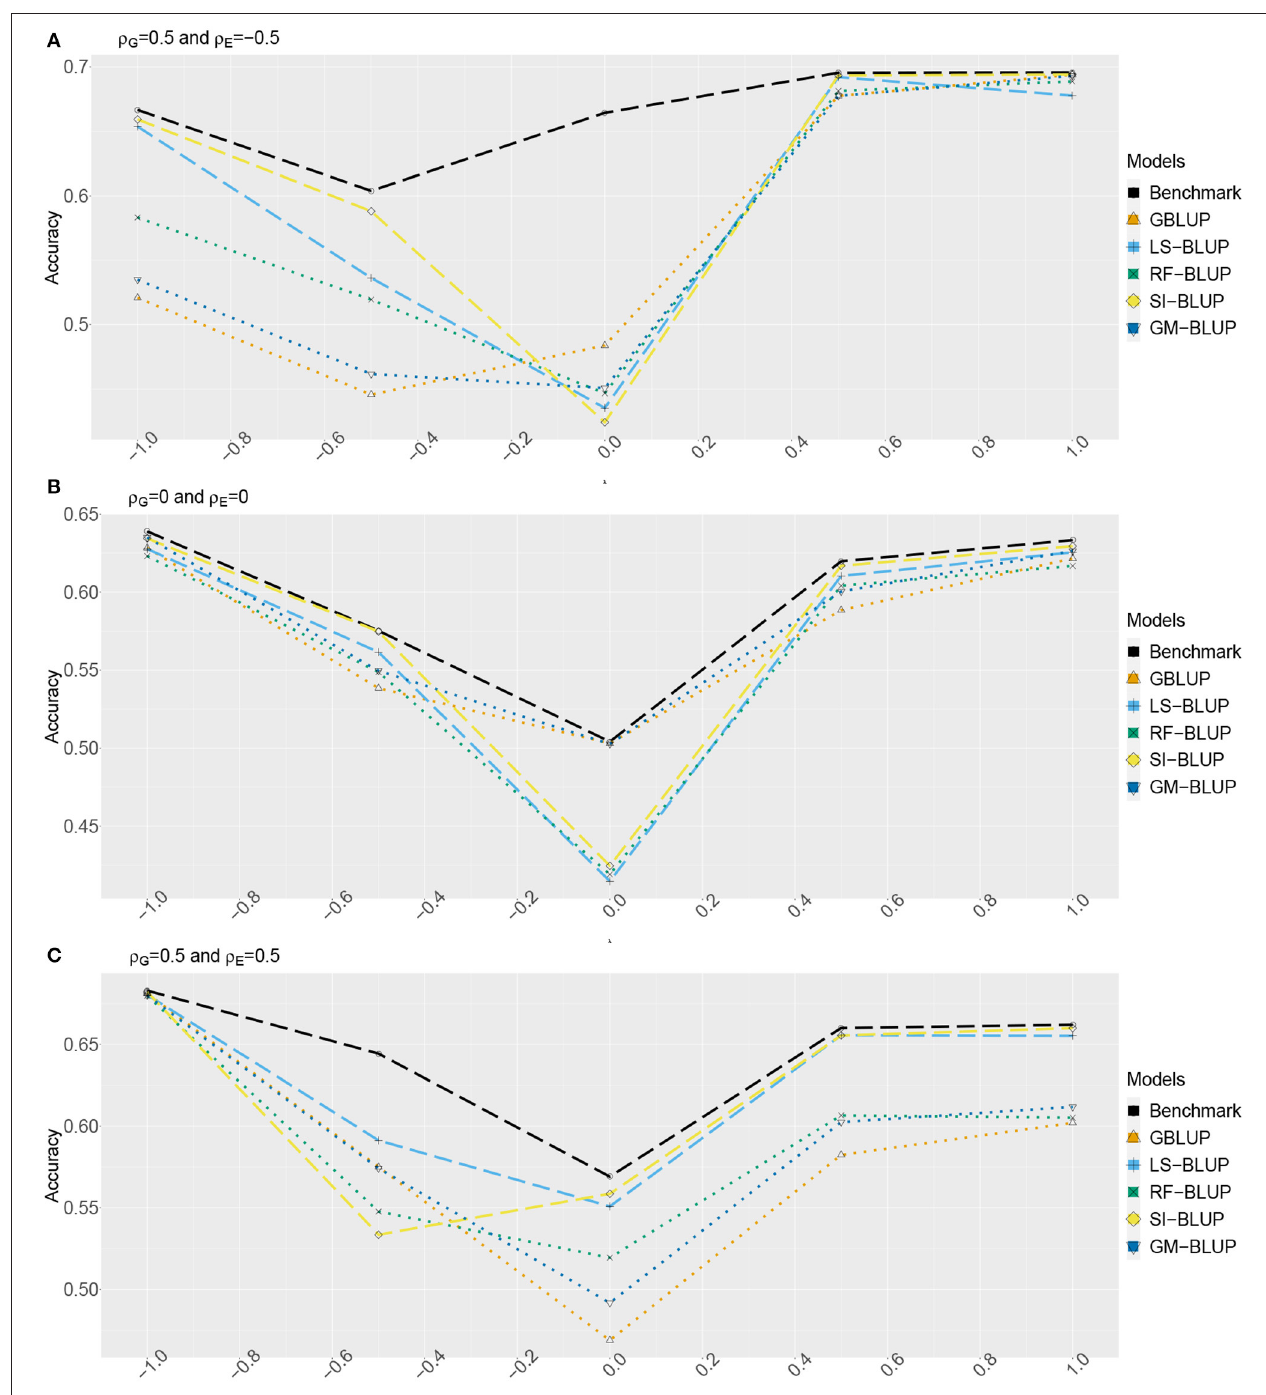
FIGURE 2 | Accuracy of genomic prediction methods in scenario 1, which for each value of λ is estimated from 50 simulated data-sets (standard errors between 0.011 and 0.042). “GBLUP” is the univariate GBLUP, and the benchmark is the multivariate GBLUP based on Y 1 , ... , Y 4 , using the true (simulated) values of the variance components (see section 2.8.1). Acronyms of the other methods are given in section 2; they use all secondary traits ( Y 2 , ... , Y 301 ), without knowledge of ( Y 2 , Y 3 , Y 4 ) being causal. λ is the size of the causal effect of ( Y 2 , Y 3 , Y 4 ) on Y 1 . ρ G is the correlation between the direct genetic effects on Y 1 , ... , Y 4 ; similarly, ρ E is the correlation between the non-genetic effects. The total genetic correlation is function of λ and ρ G . (A) ρ G